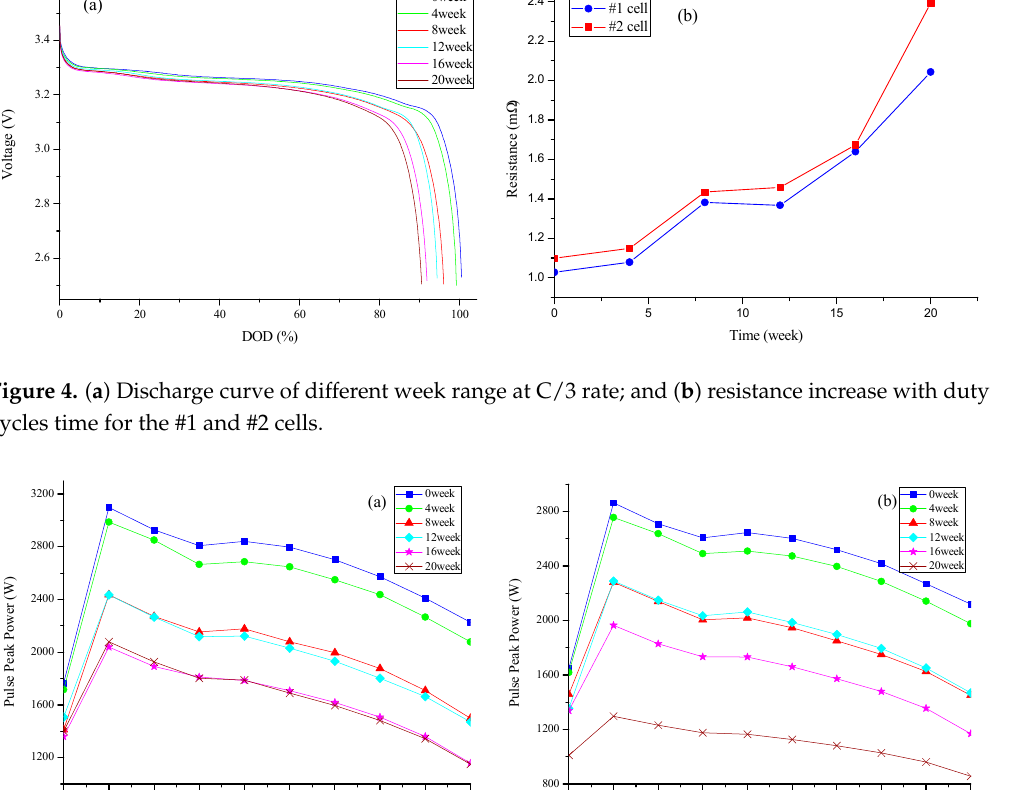
6 of 13 Figure 3. Proportion of capacity loss varying with time for ratio = 0.5 and 0.75, respectively.